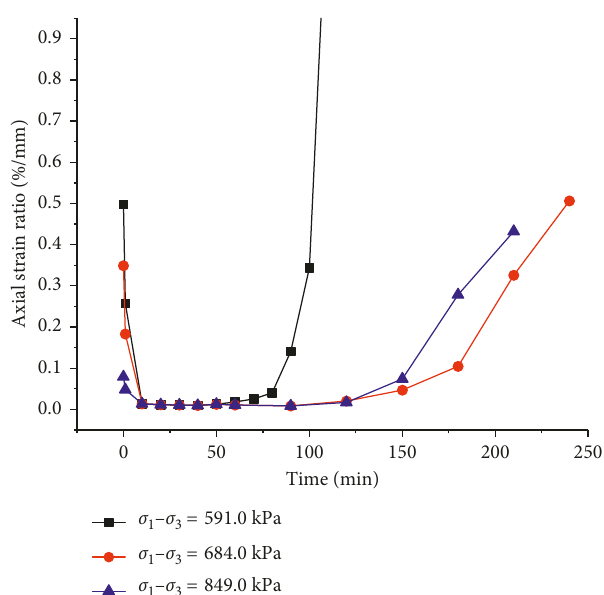
Figure 4: Relation between the creep strain ratio and time under different confining pressures.